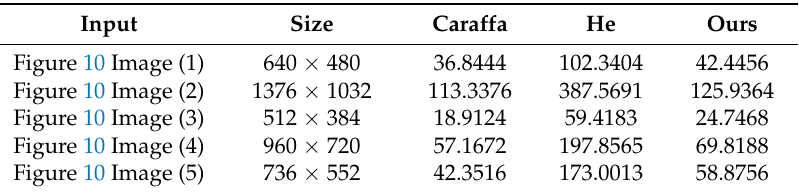
Table 3. Comparisons of arithmetic effectivity in Figure